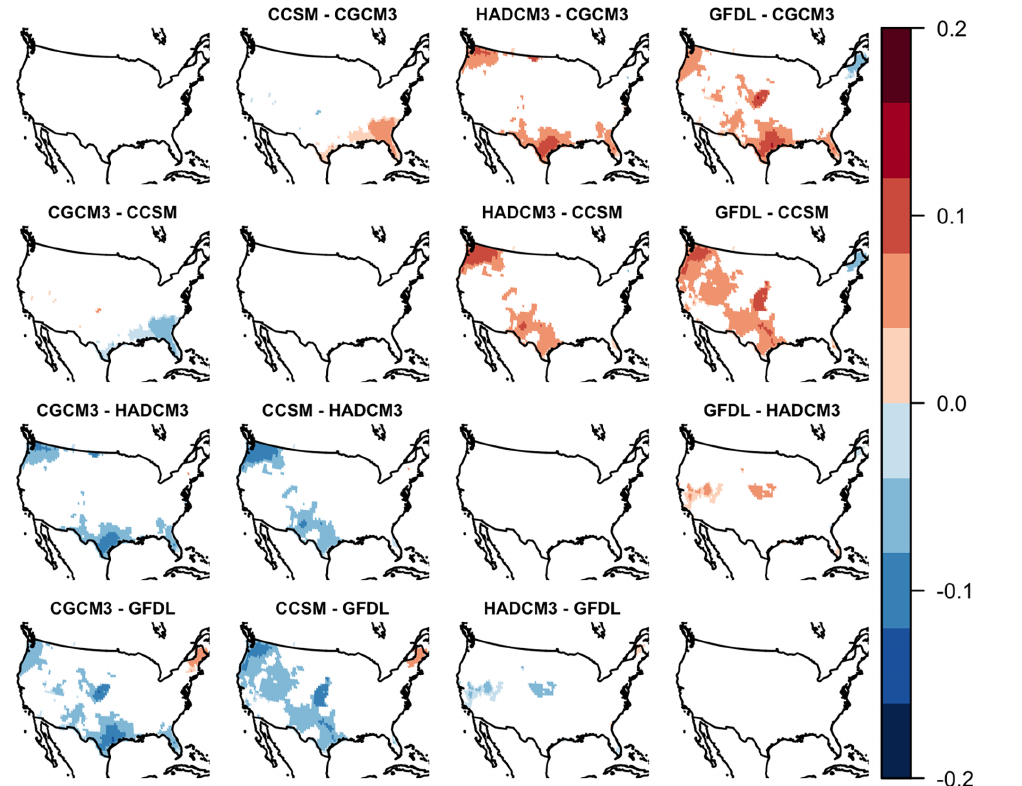
Figure 14. A heat map of the estimated average pairwise difference in rate of temperature change for GCM effects for the ASL model. Only significant locations at the 0.10 level using pointwise inference are